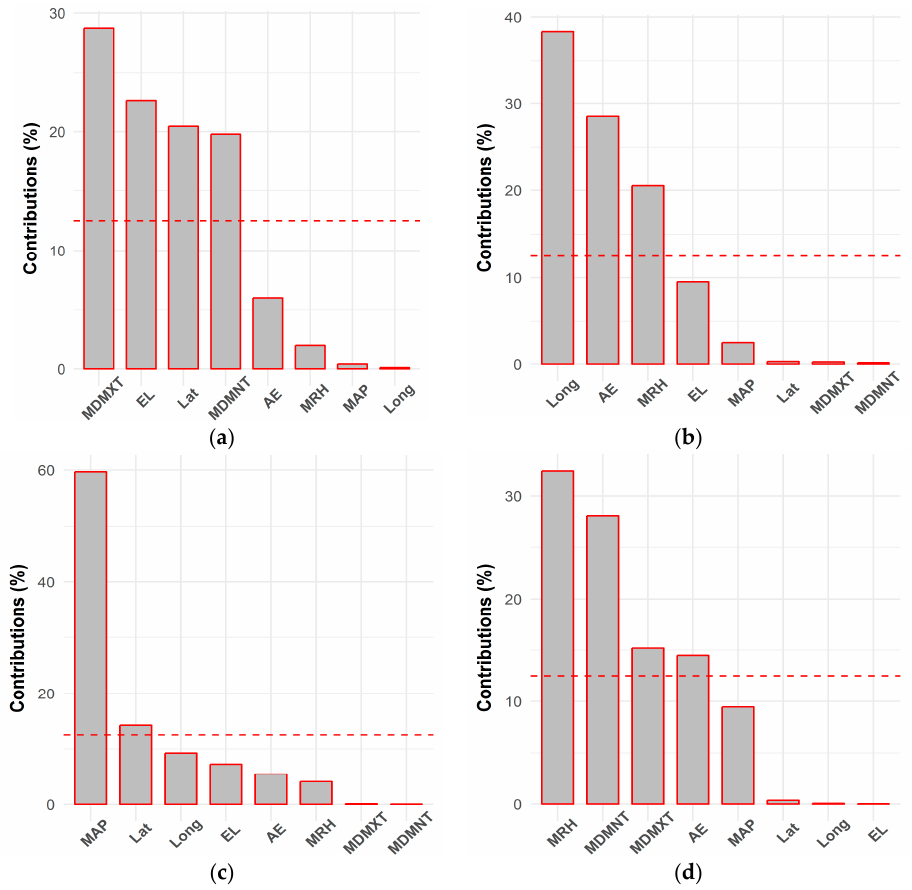
Figure 7. Contribution percentage of eleven attributes to the following principal components: ( a ) first principal component; ( b ) second principal component; ( c ) third principal component; ( d ) fourth principal component.